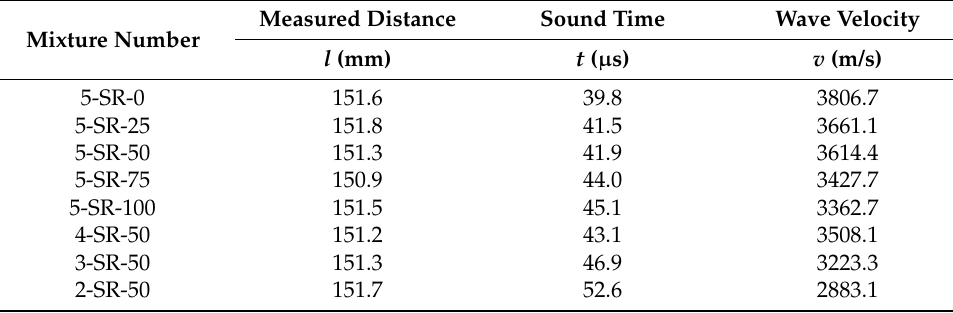
Table 7. Ultrasonic test results of specimens before freeze–thaw cycles. Mixture